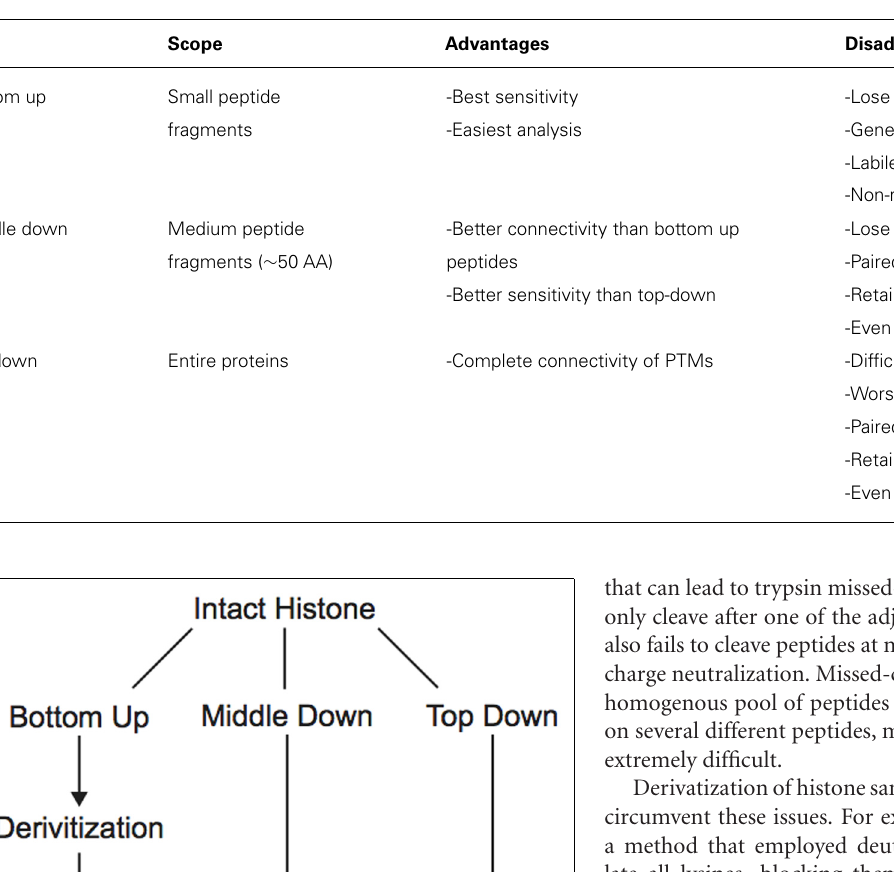
Table 1 | Comparison of MS techniques.